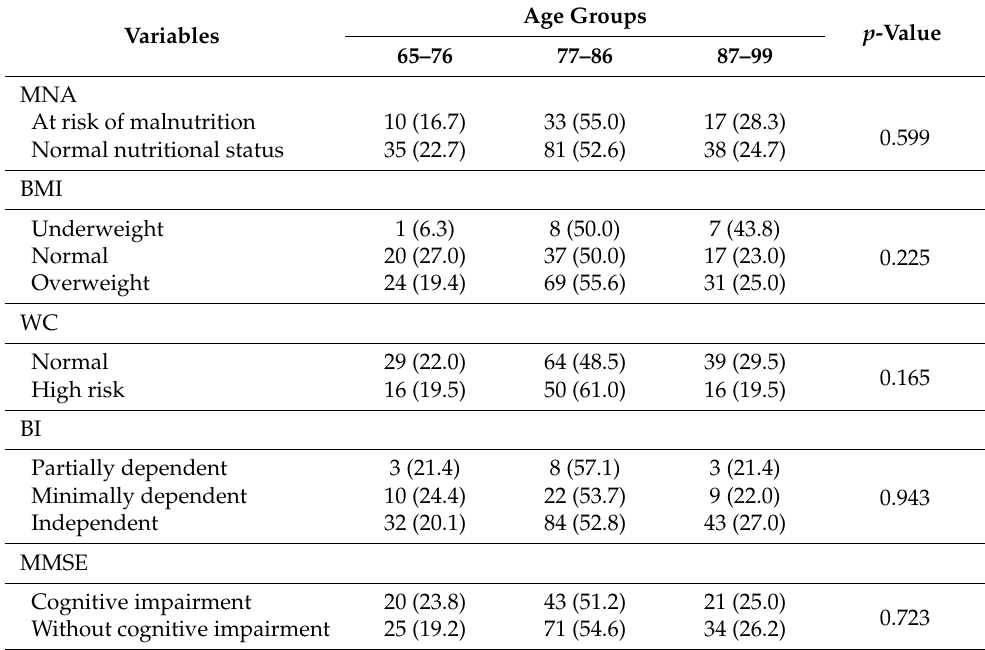
Table 2. Age effects on nutritional status, nutritional risk, self-dependence in activities of daily living, and cognitive status.